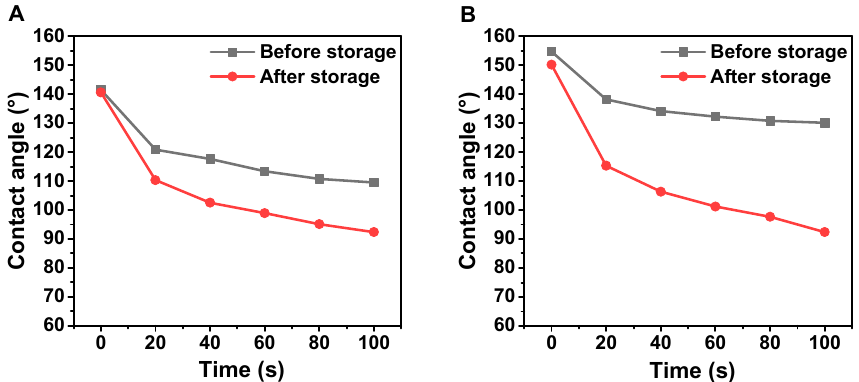
Figure 13. ( A ) Poplar cross section CA after 30-day storage. ( B ) Poplar tangential section CA after 30-day storage.